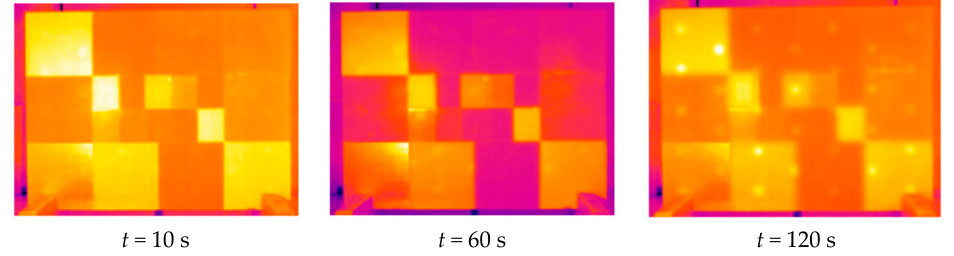
Figure 14. Example of experimental thermograms obtained (at t = 10 s, t = 60 s and t = 120 s).